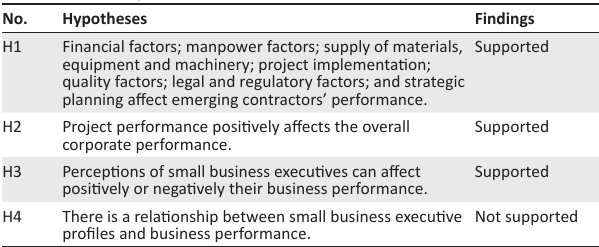
TABLE 7: Summary of results.